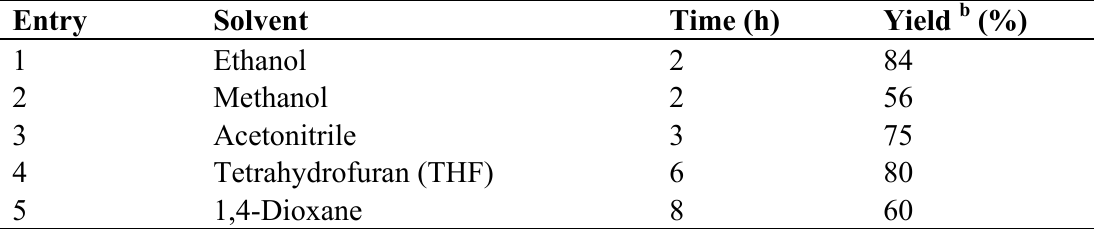
Table 1. Optimization of solvent effect on the model reaction a .